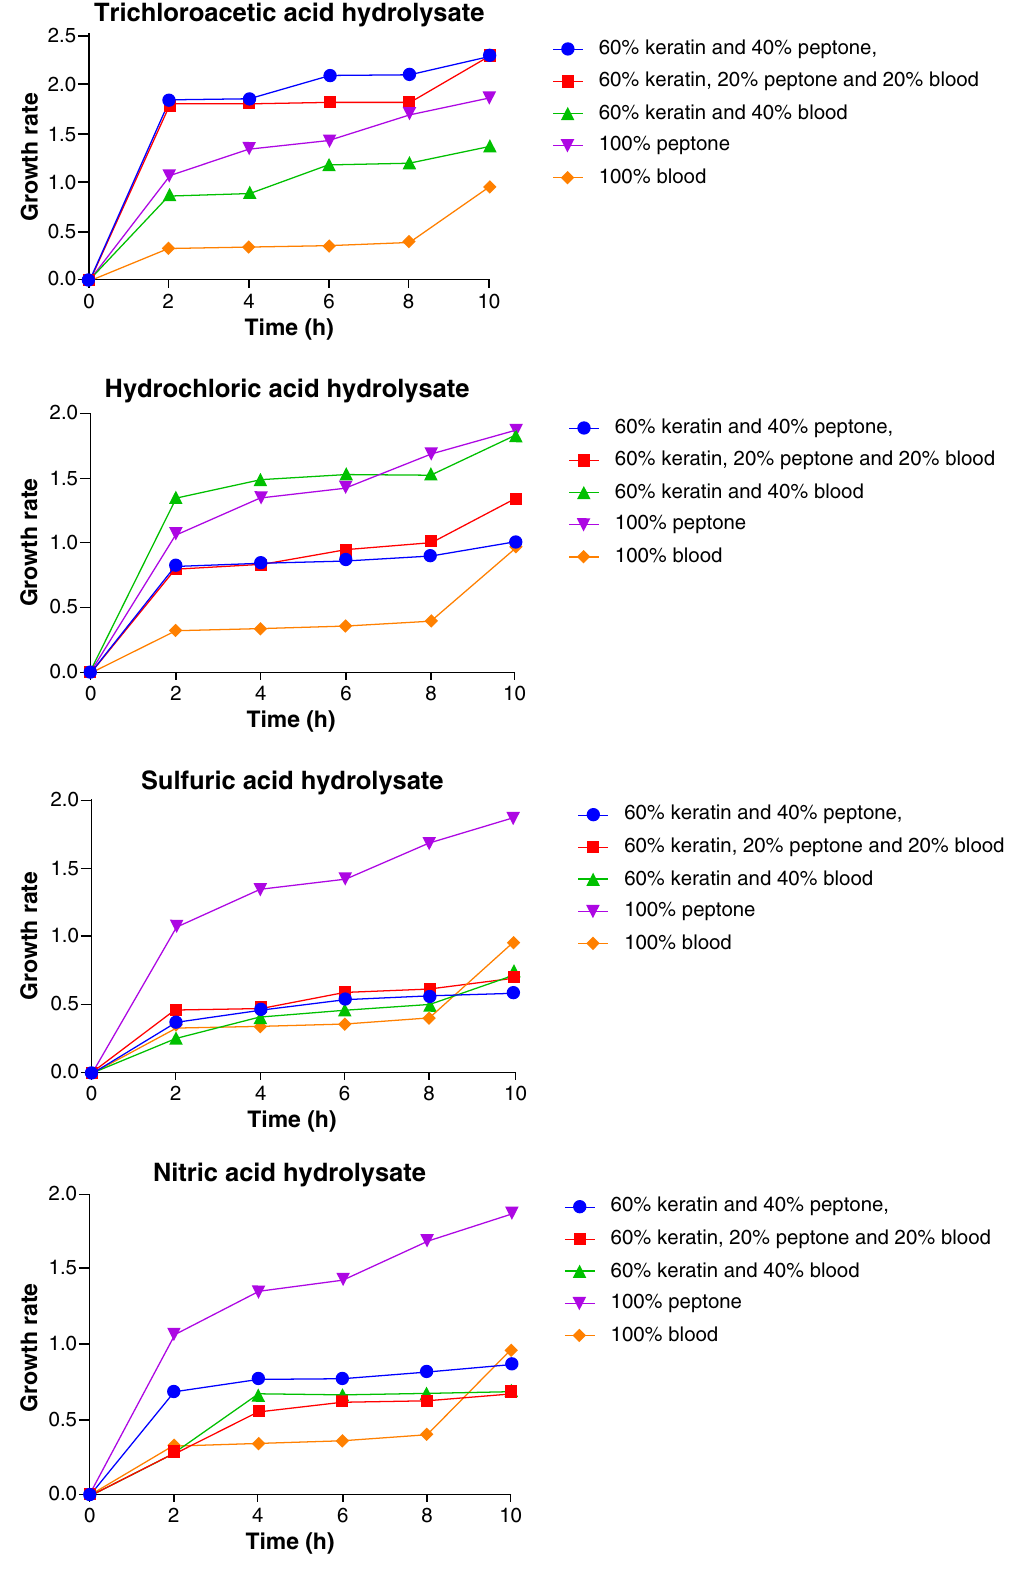
Figure 2. Growth rate of Candida tropicalis in media with the TCA, HCl, H